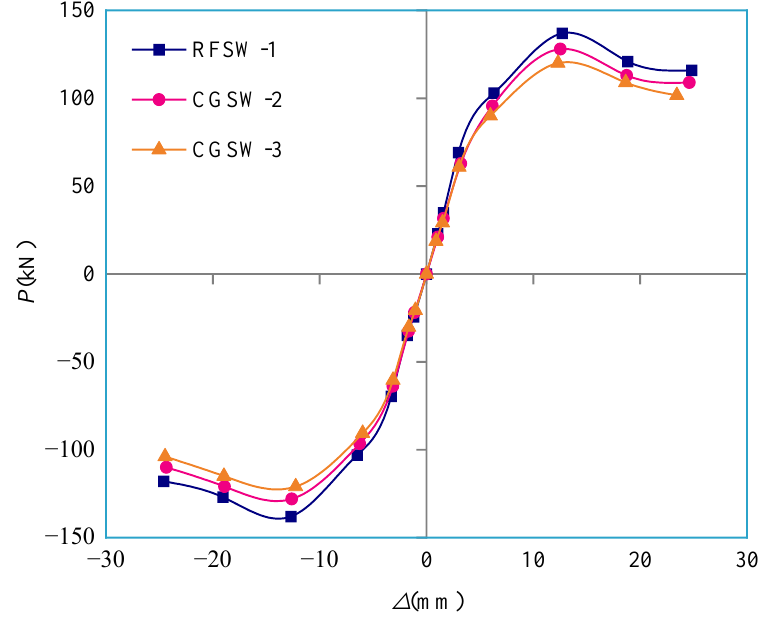
Figure 10. Backbone curves of the specimens.